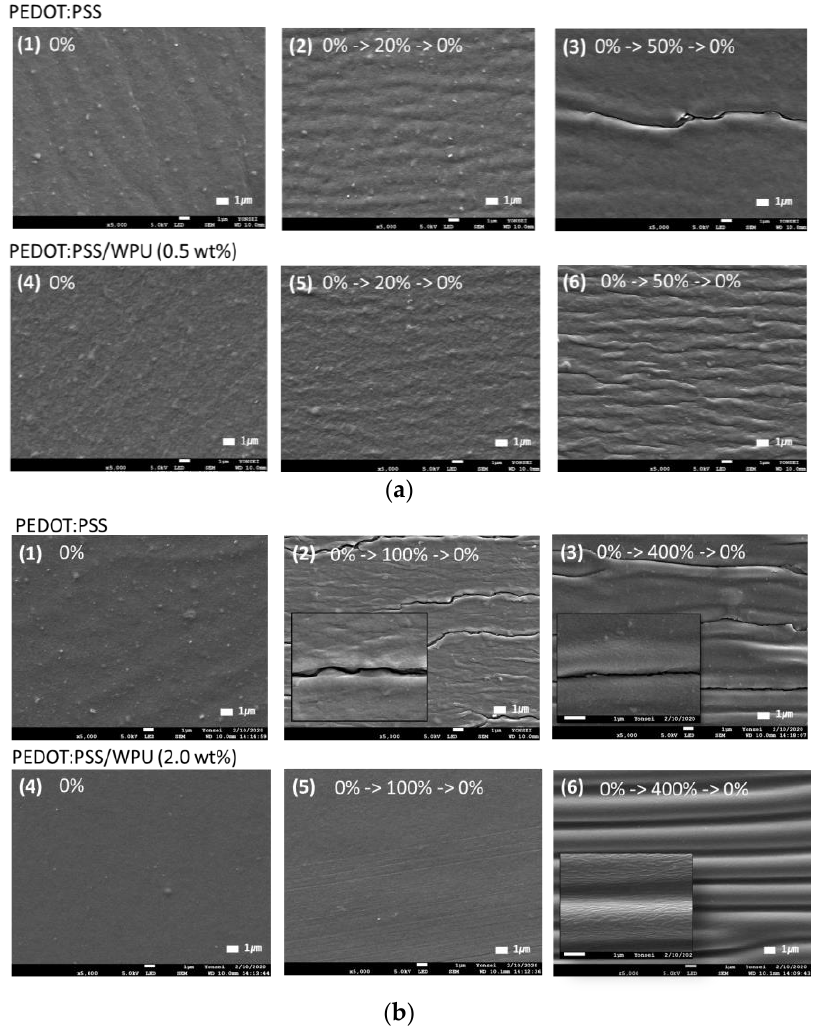
Figure 8. Scanning electron microscope (SEM) images of ( a ) PEDOT:PSS only and PE- DOT:PSS/nonionic WPU (0.5 wt%) coated on TPU substrate after strain and release with 20 and 50% strain. ( b ) PEDOT:PSS only and PEDOT:PSS/nonionic WPU (2.0 wt%) coated on TPU substrate after strain and release with 50 and 100% strain. ( 1 ) and ( 4 ) under 0% strain, ( 2 ), ( 3 ), ( 5 ) and ( 6 ) after one stretch-release different strains.